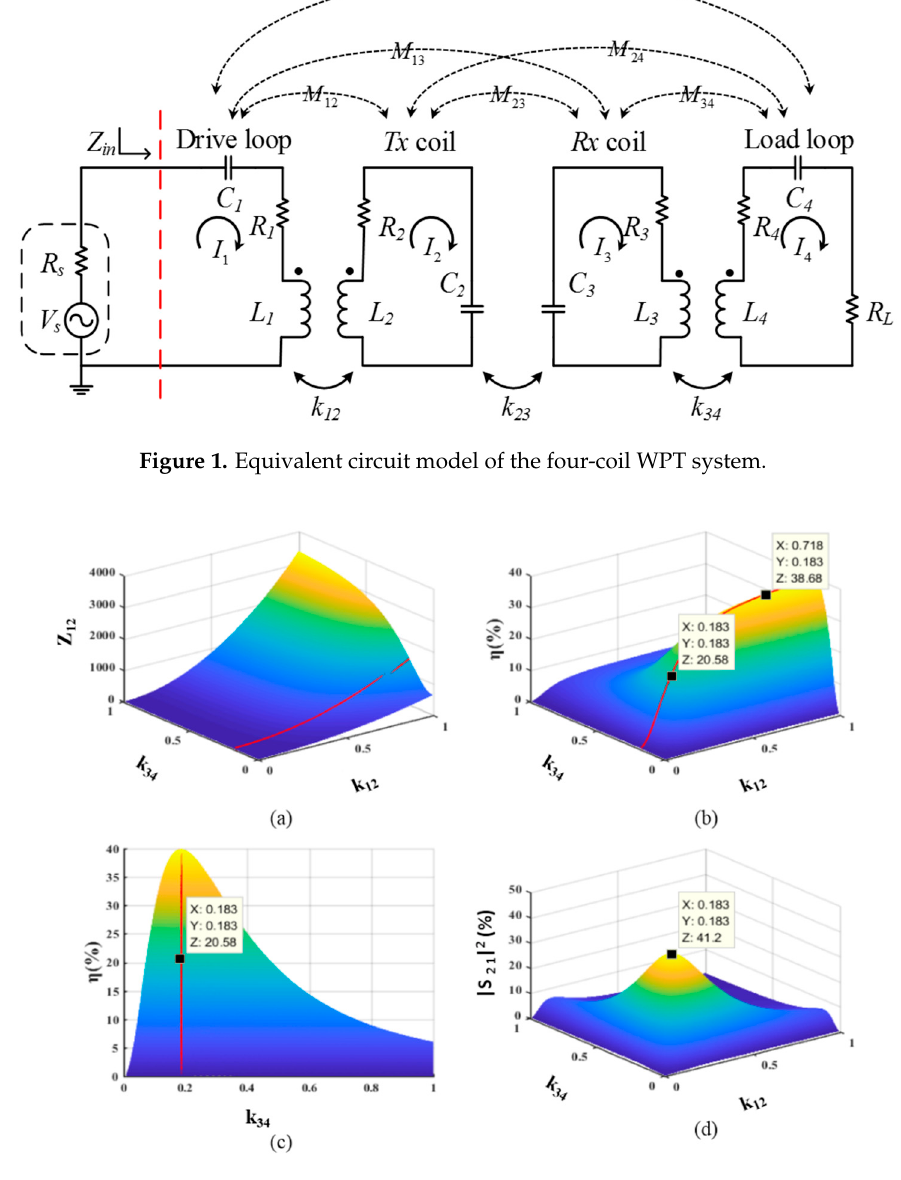
Figure 2. Numerical analysis results of the four coil system, ( a ) Z 12 versus k 12 and k 34 , ( b ) transfer efficiency versus k 12 and k 34 , ( c ) is the y-z view of ( b , d ) | S 21 | 2 versus k 12 and k 34 .